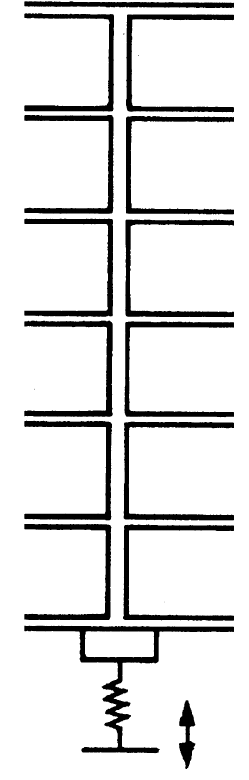
Fig. 8 Simplified building model consisting of the soil, a wall or column and the